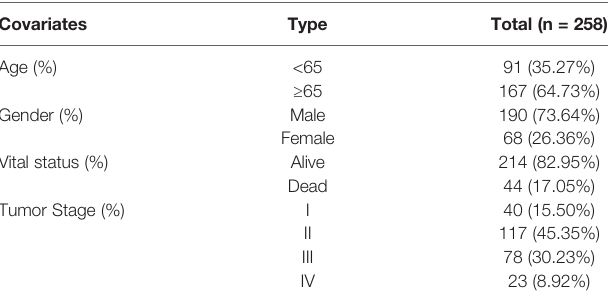
TABLE 2 | Clinical characteristics of the HCC patients in the ICGC database. Covariates